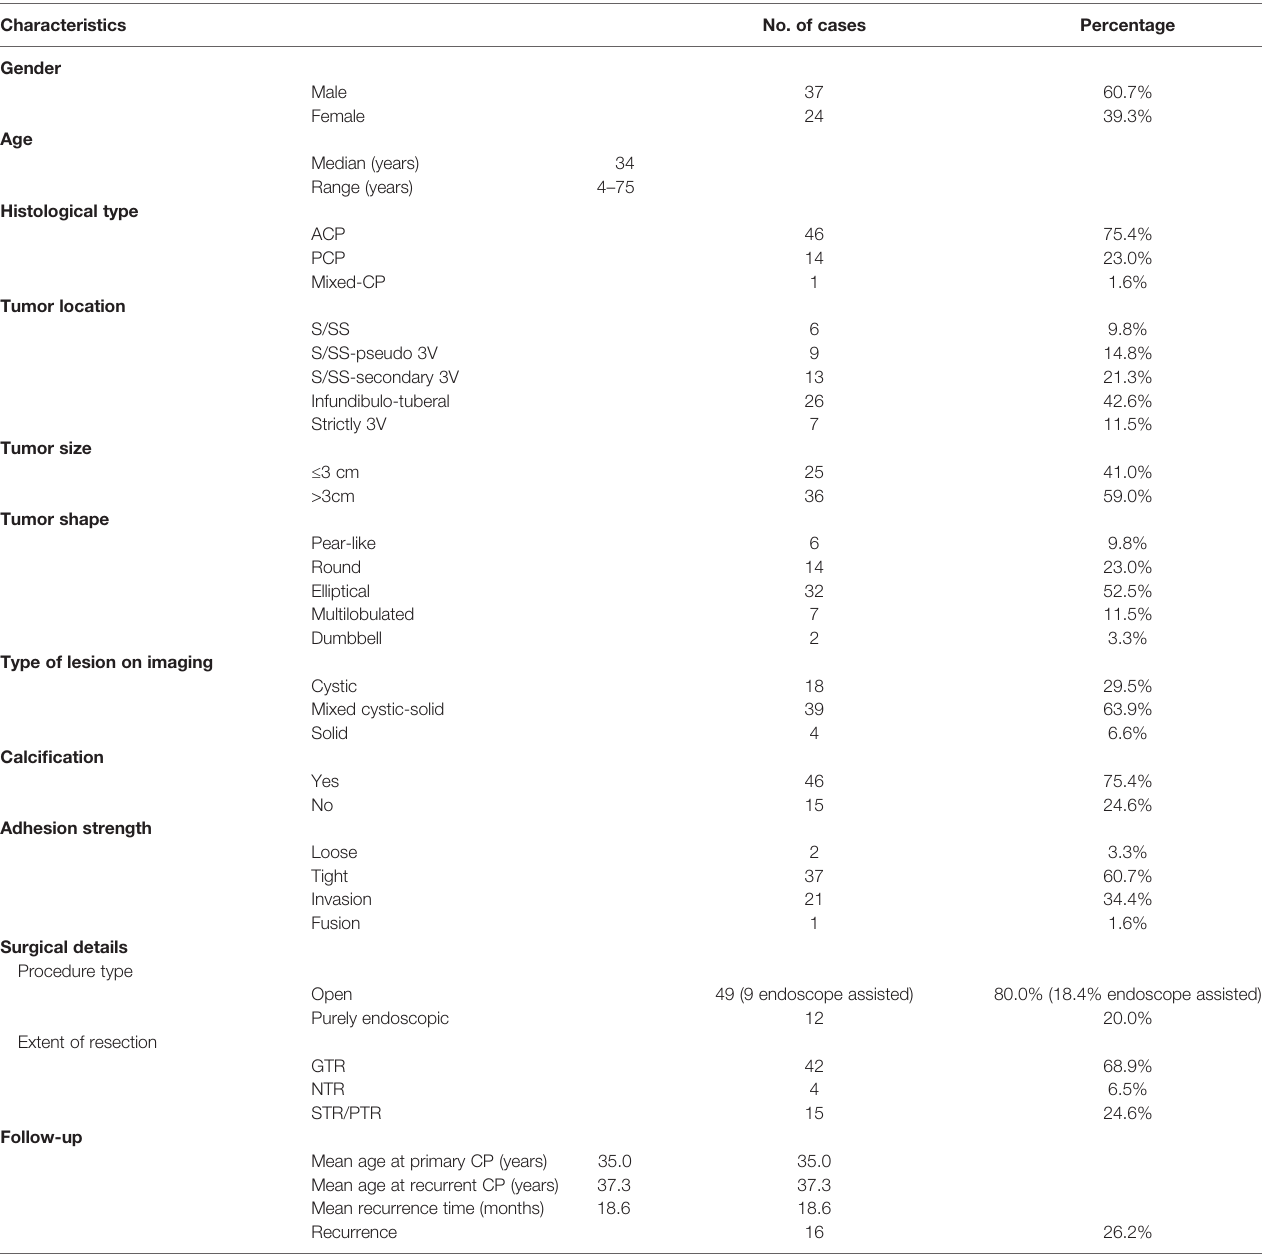
TABLE 1 | Clinical characteristics of